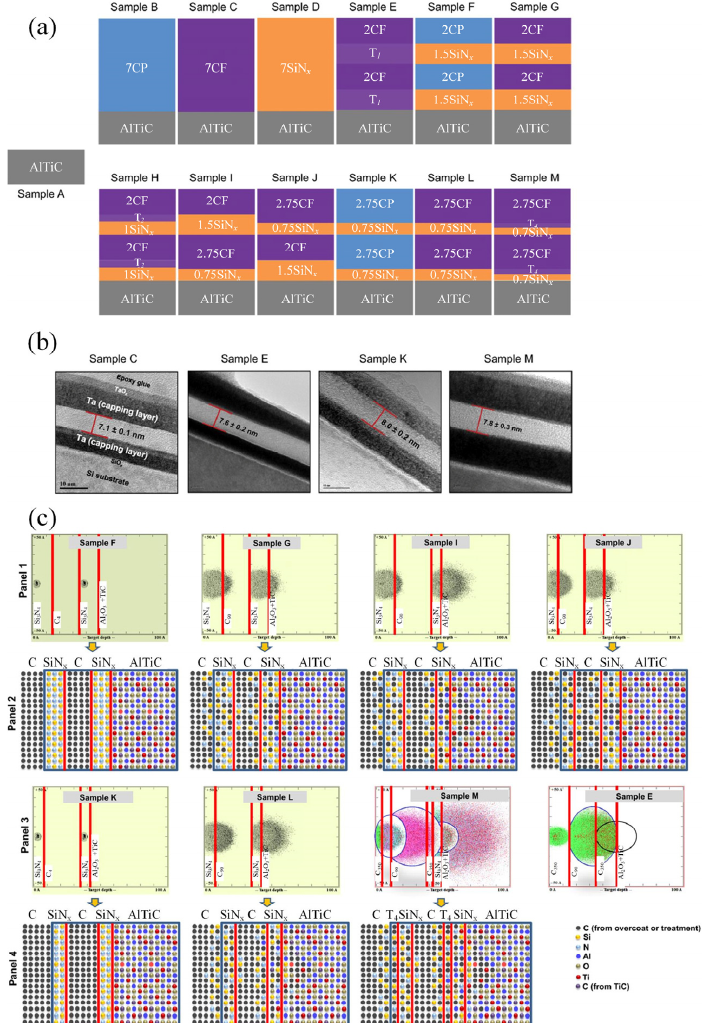
Figure 6. ( a ) Schematic diagram of the designing of coating samples; ( b ) cross-sectional images of the coatings; ( c ) TRIM simulations of the selected coating samples, showing the extent of atomic mixing. In this figure, AlTiC represents Al 2 O 3 + TiC composite material; CP represents sputter-deposited carbon overcoat; CF represents FCVA-deposited carbon overcoat; T represents high-energy carbon treatment. Reprinted with permission from [106].